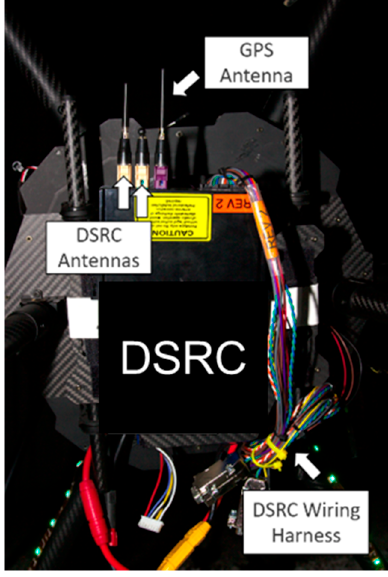
Figure 3. DSRC modem in the UAV platform.